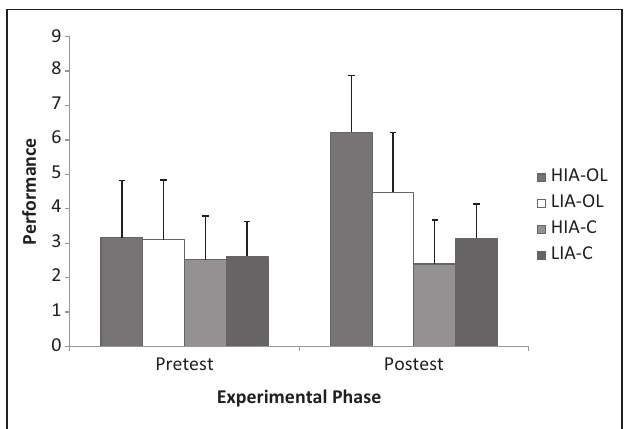
FIGURE 2 | Gymnastics performance as a function of group (HIA-OL = high imagery ability observational learning; LIA-OL = low imagery ability observational learning; HIA-C = high imagery ability control; LIA-C = low imagery ability control) and experimental phase.